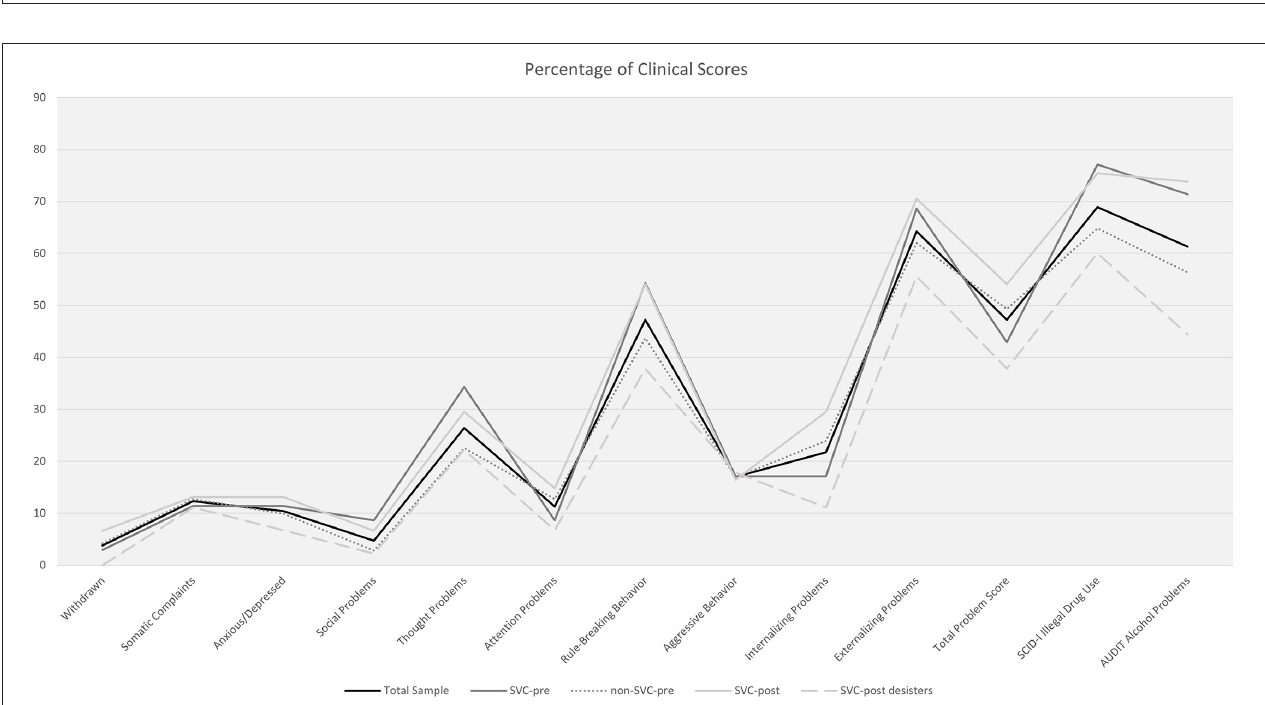
FIGURE 1 | YSR/YASR T-Scores for the total sample (N = 106) and for SVC offender status.